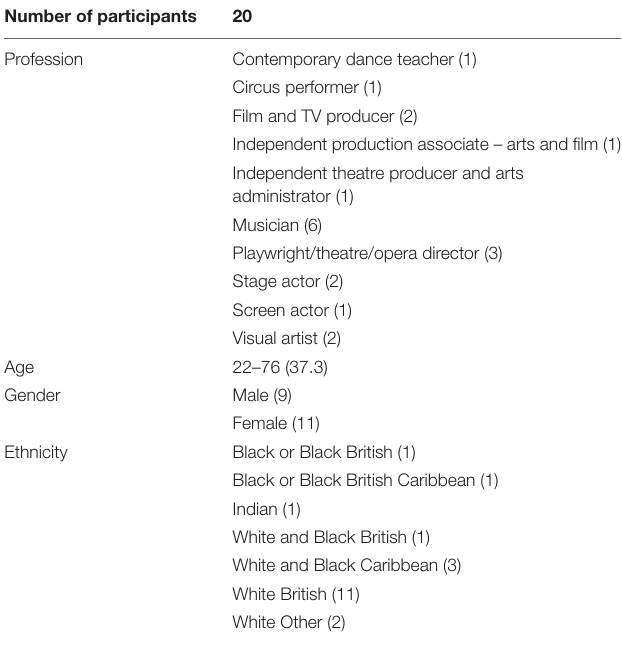
TABLE 1 | Characteristics of